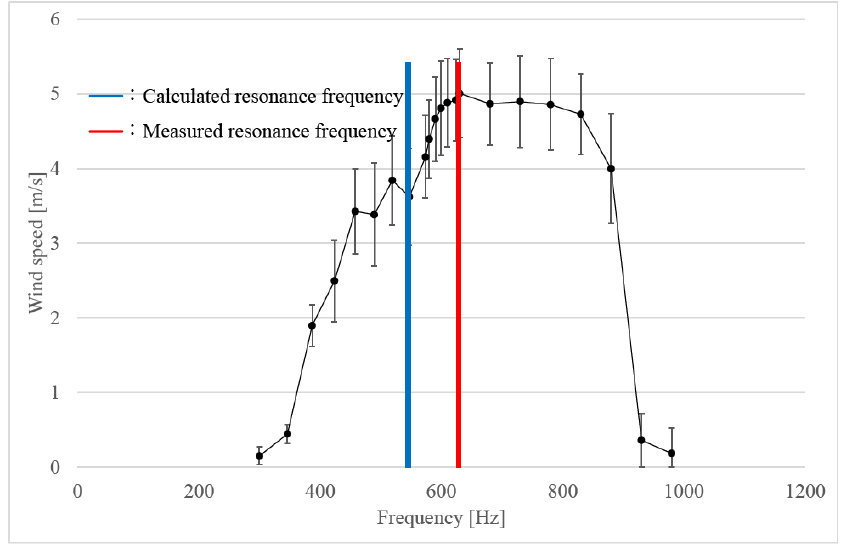
Figure 2. Wind velocity vs. frequency at 5 mm sound hole.